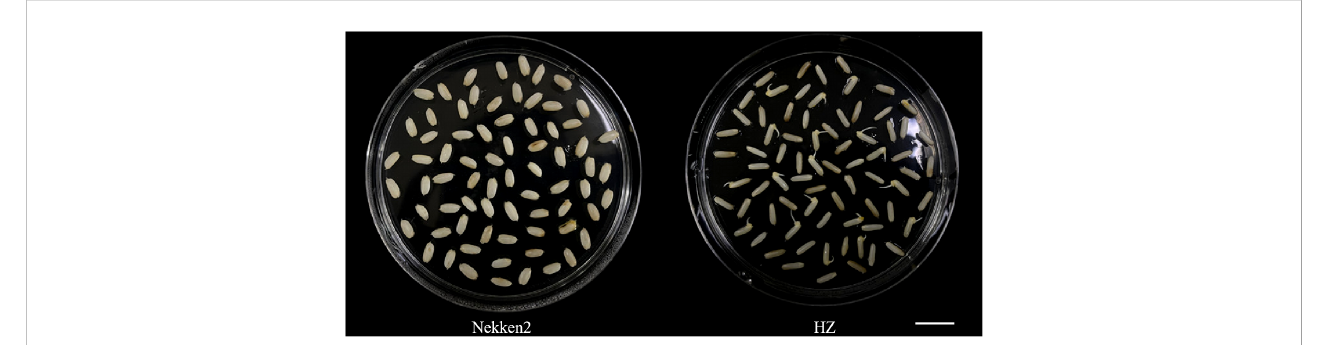
FIGURE 2 Phenotype diagram of germination rate of Huazan and Nekken2 under 80mM salt stress, bar=5cm.